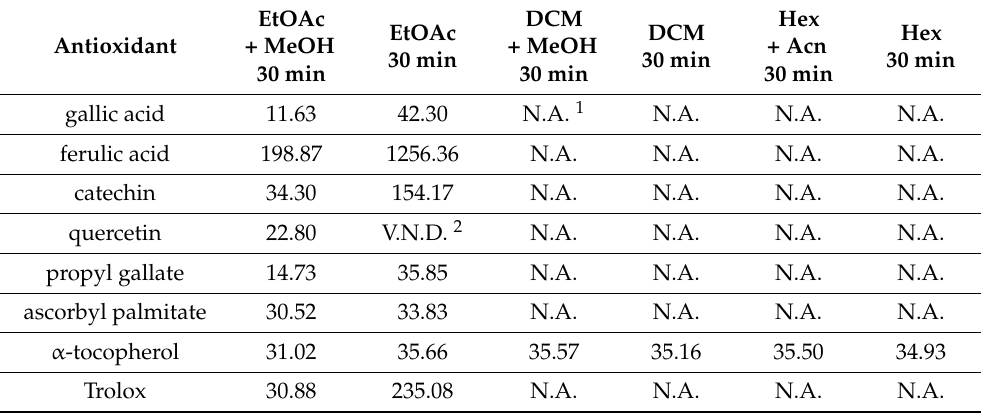
Table 8. IC 50 values ( µ M) determined against DPPH radicals applied in ethyl acetate (radical solution in methanol or ethyl acetate), dichloromethane (radical solution in methanol or dichloromethane) and hexane (radical solution in acetone or hexane) after standard reaction